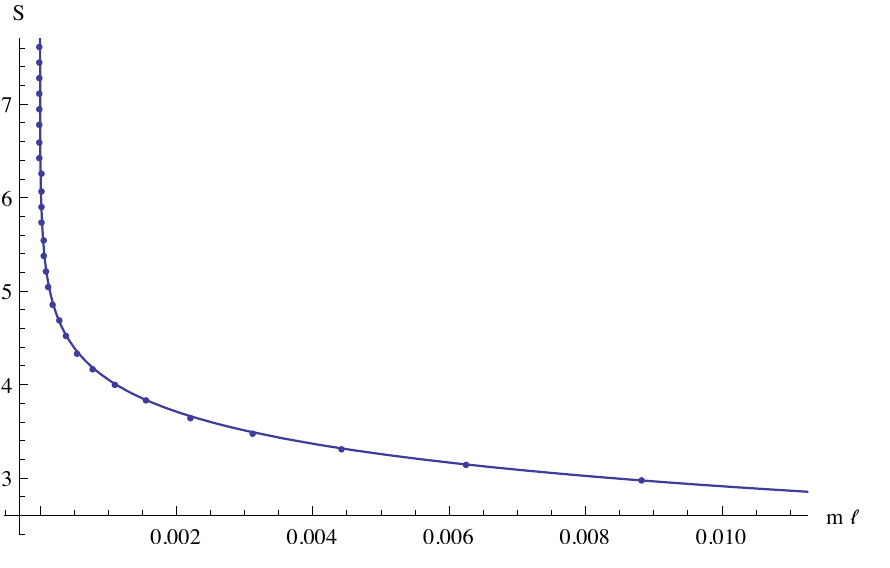
Figure 3 . S vs. m ‘ for a subchain of 50 harmonic oscillators within a longer chain of 500 oscillators with periodic boundary